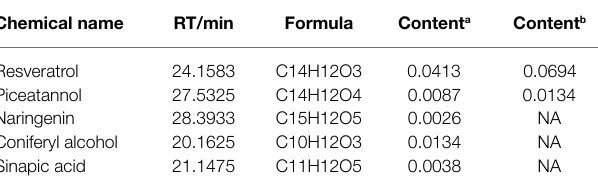
TABLE 2 | Relative content of specific secondary metabolites of